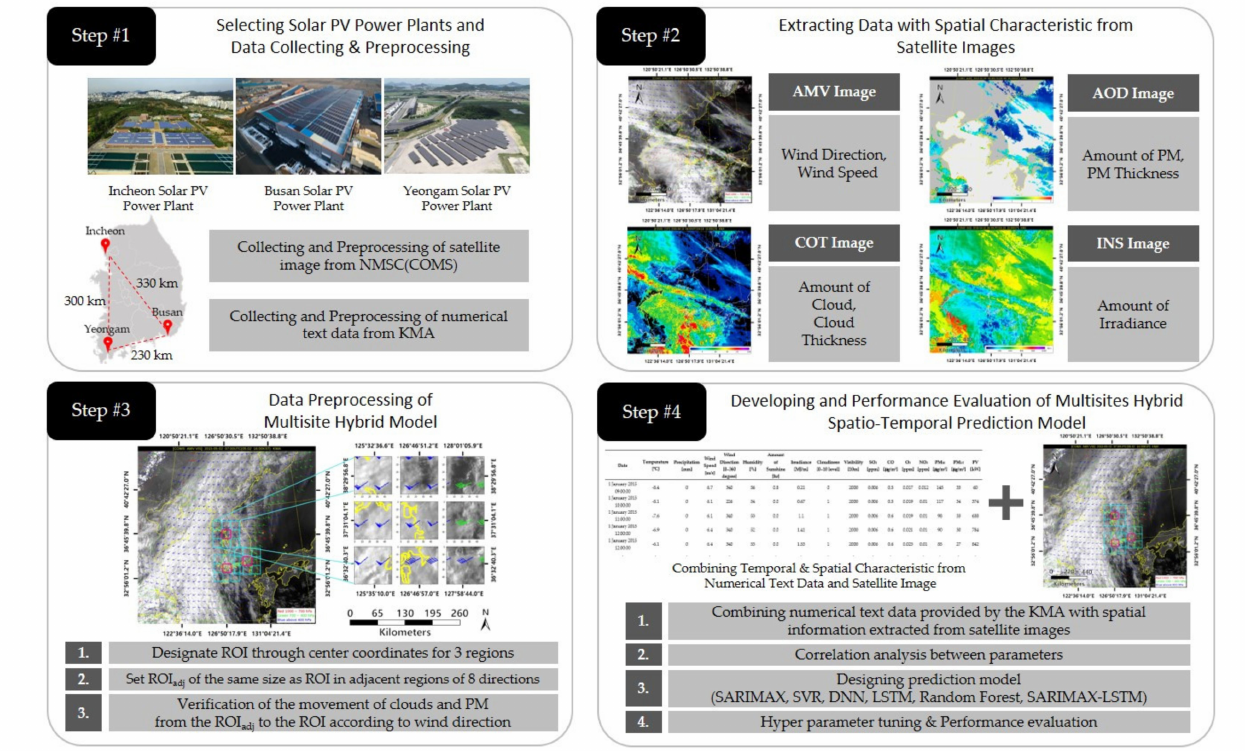
Figure 1. The research framework of this